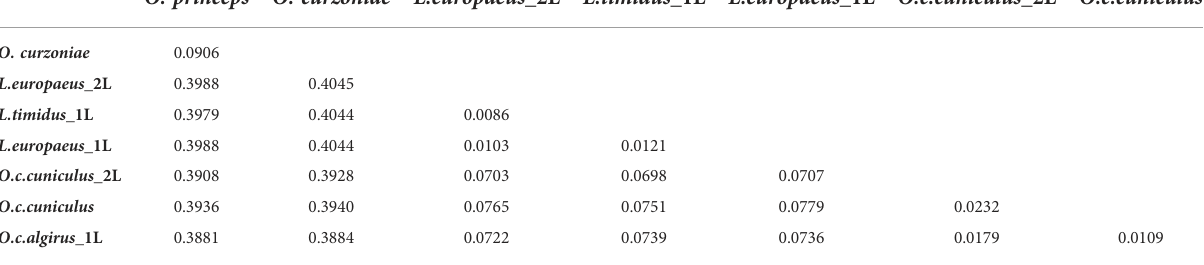
TABLE 3 Nucleotide genetic distances between pIgR alleles of studied Lagomorpha species.